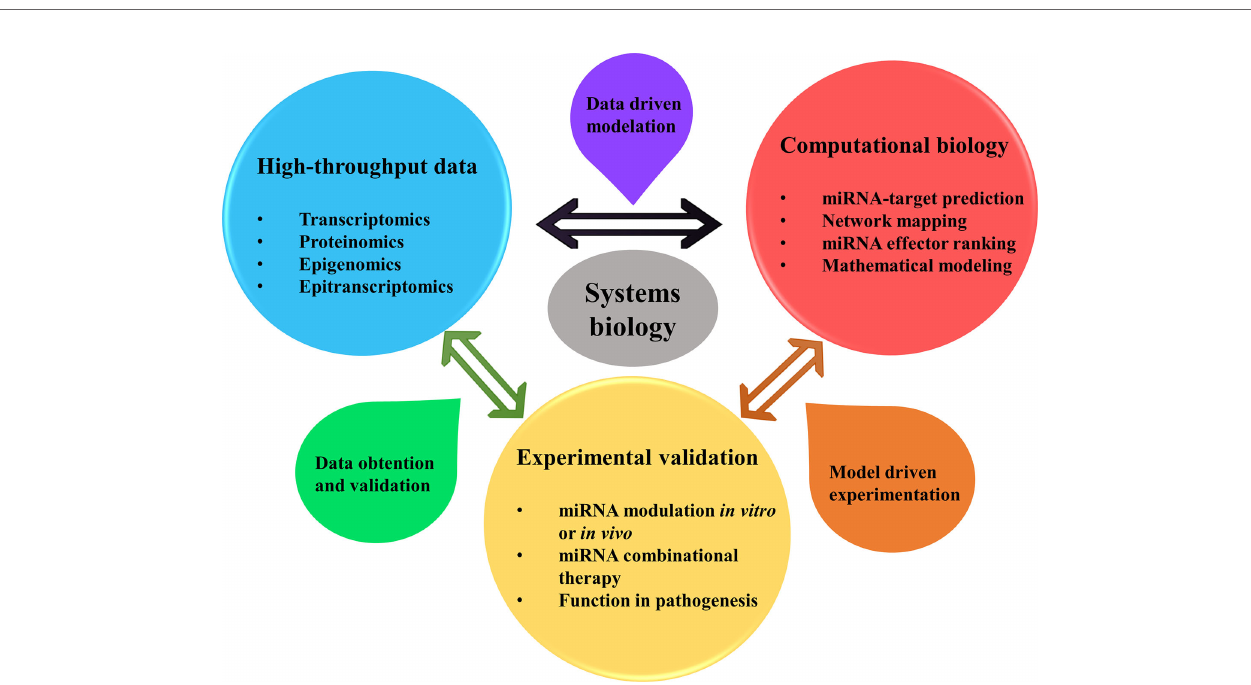
FIGURE 1 | Systems biology approaches allow for better understanding the roles of miRNAs in pathophysiology, diagnosis, and treatment of asthma and COPD. Being miRNAs regulators of multiple genes expression affecting thus several pathways simultaneously, a comprehension of the global picture of their regulation is in need. System biology approach helps in this matter, by using a data driven method for creating computational models from previous data of high-throughput experimentation (transcriptomics, proteomics, epigenomics and epitranscriptomics) that could be obtained from the literature. Network mapping modeling allows determining the interaction between miRNAs, genes (or proteins) and phenotype and clinical data. Besides, mathematical models can help fi nding key miRNAs with power to alter the core of cellular pathway regulation and performance. After this, model driven experimentation allows to con fi rm the predicted targeting by miRNAs in cooperation by their modulation in vivo or in vitro , uncovering their role in the disease and their use in therapy. Finally, this new data obtained and validated can be summed up to con fi rm previous high-throughput results, enlarging the available data of miRNA regulation in asthma or